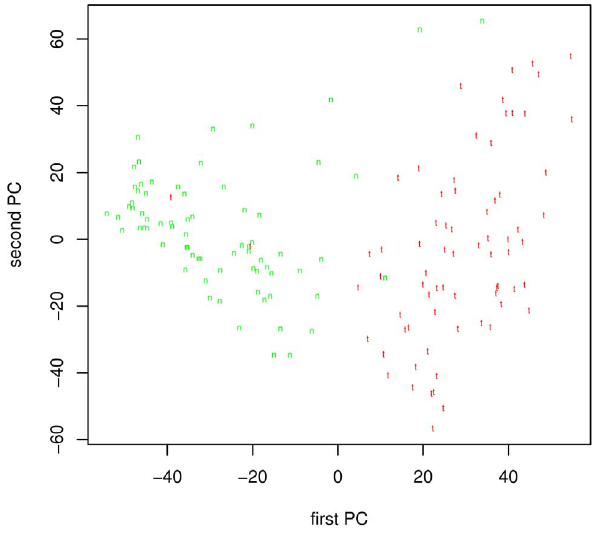
Figure 3. PCA analysis of GNCA patients (144 chips from 72 patients). Red ‘‘t ‘‘ represents tumor and green ‘‘n’’ represents matched normal tissue.